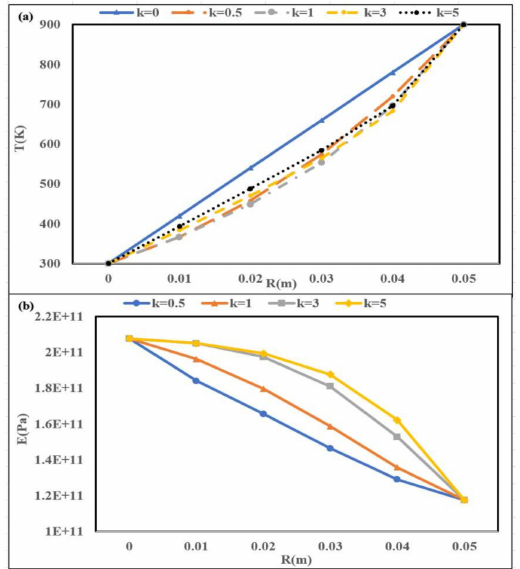
Figure 4. Variation in material properties across the radius. ( a ) Temperature; ( b ) Young’s